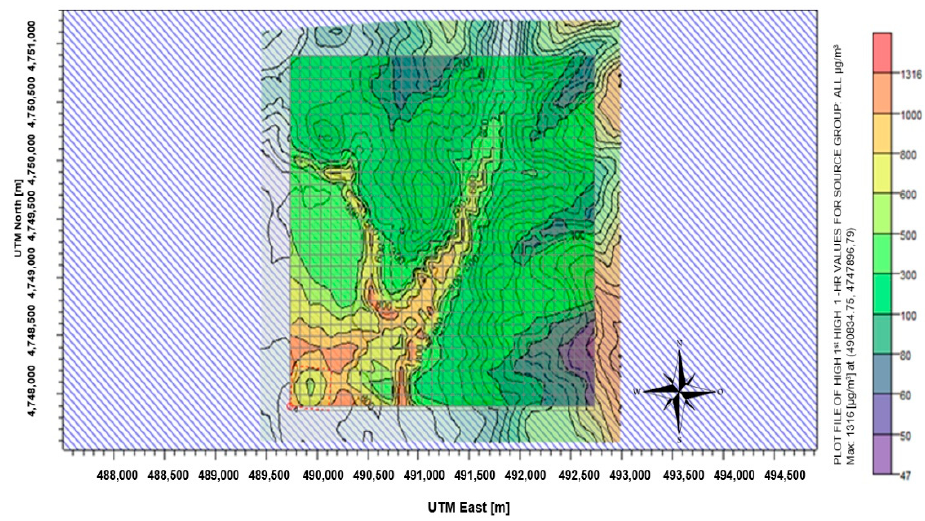
Figure 10. The highest calculated concentration for extreme wind conditions.